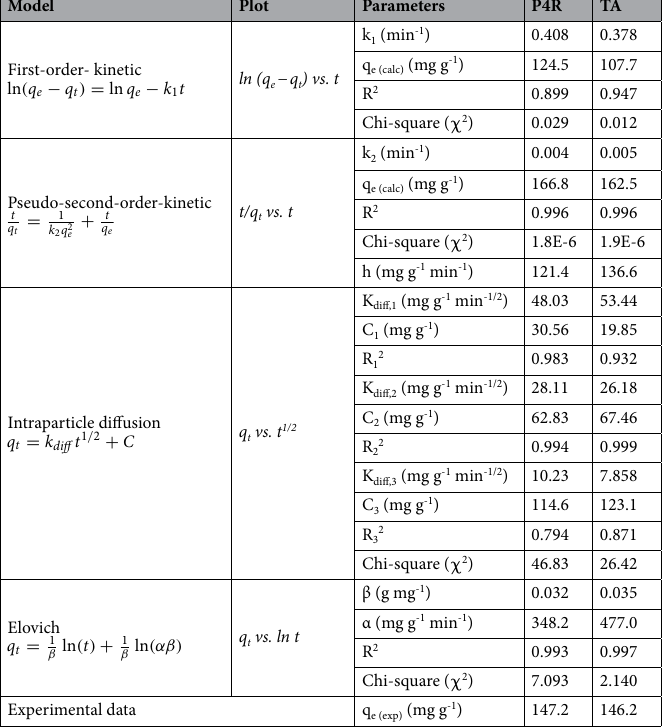
Table 5. Kinetic parameters and correlation coefficient for different adsorption kinetic models for TA and P4R dyes adsorption.